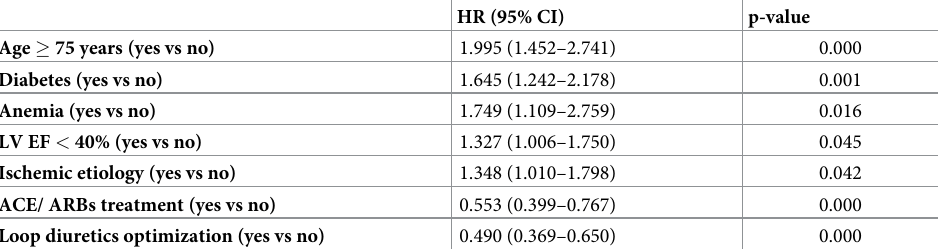
Table 5. Predictors of all-cause of 1-year rehospitalization and mortality in CHF patients (multivariable analysis).